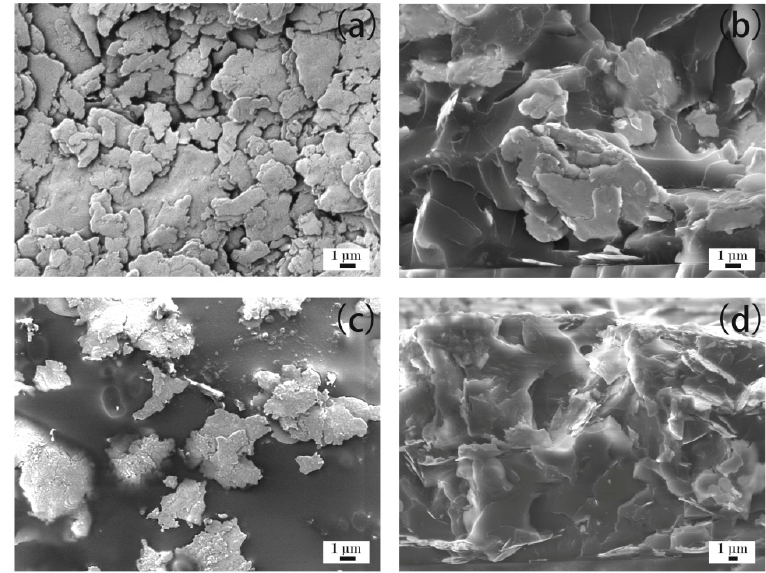
Figure 4. ECAs filled with 20 wt % Ag flakes. ( a ) ECAs fabricated by the powder spraying process; and ( b ) cross sections of ECAs fabricated by the powder spraying process; ( c ) ECAs fabricated by the conventional process; and ( d ) cross sections of ECAs fabricated by the conventional